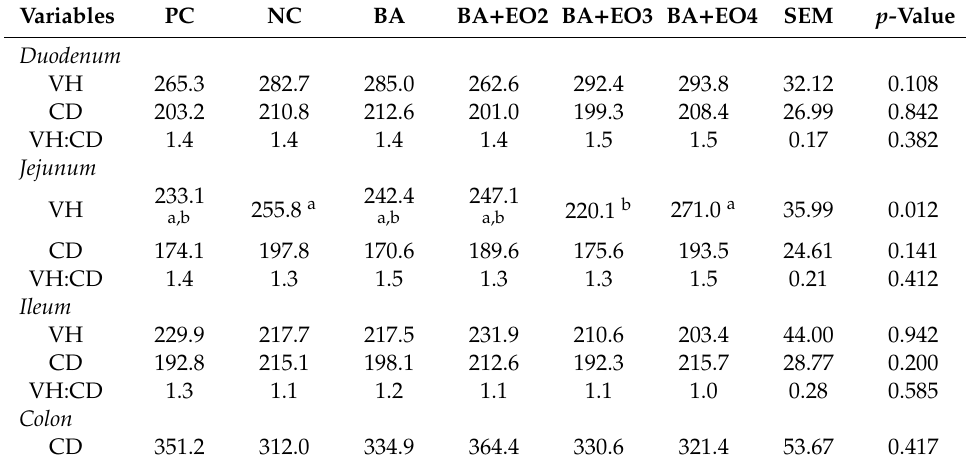
Table 8. E ff ect of experimental diets on the intestinal morphology of piglets challenged with E. coli F4.